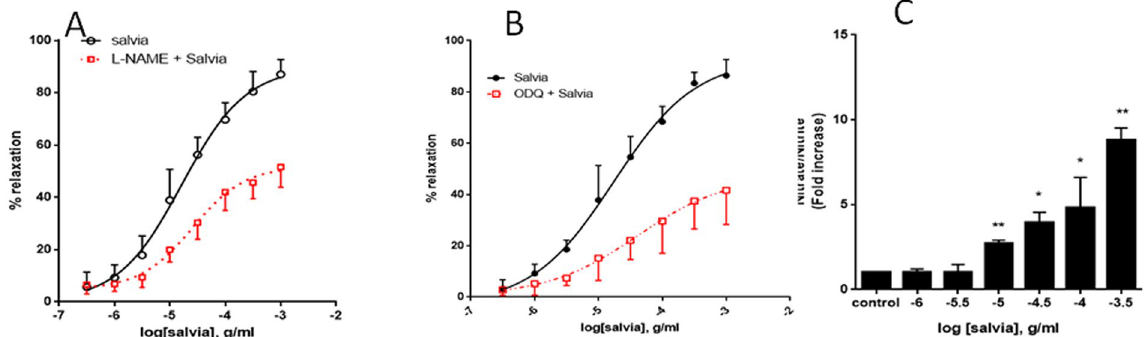
Figure 4. Effect of L-NAME or ODQ on SF-induced relaxation. ( A ) Endothelium-intact rings were incubated with cumulative doses of SF in the absence (circles) or presence of L-NAME (100 µ M; squares. Data represent mean ± SEM (n = 7; p < 0.01 for Salvia versus L-Name plus Salvia). ( B ) Endothelium-intact rings were incubated with cumulative doses of SF in the absence (circles) or presence of ODQ (1 µ M; squares). n = 7; p < 0.01 for Salvia versus ODQ plus Salvia. ( C ) Endothelium-intact rings were incubated with increasing doses of SF and levels of NO determined. n = 3; * denotes a p < 0.05 and ** a p < 0.01 (compared to